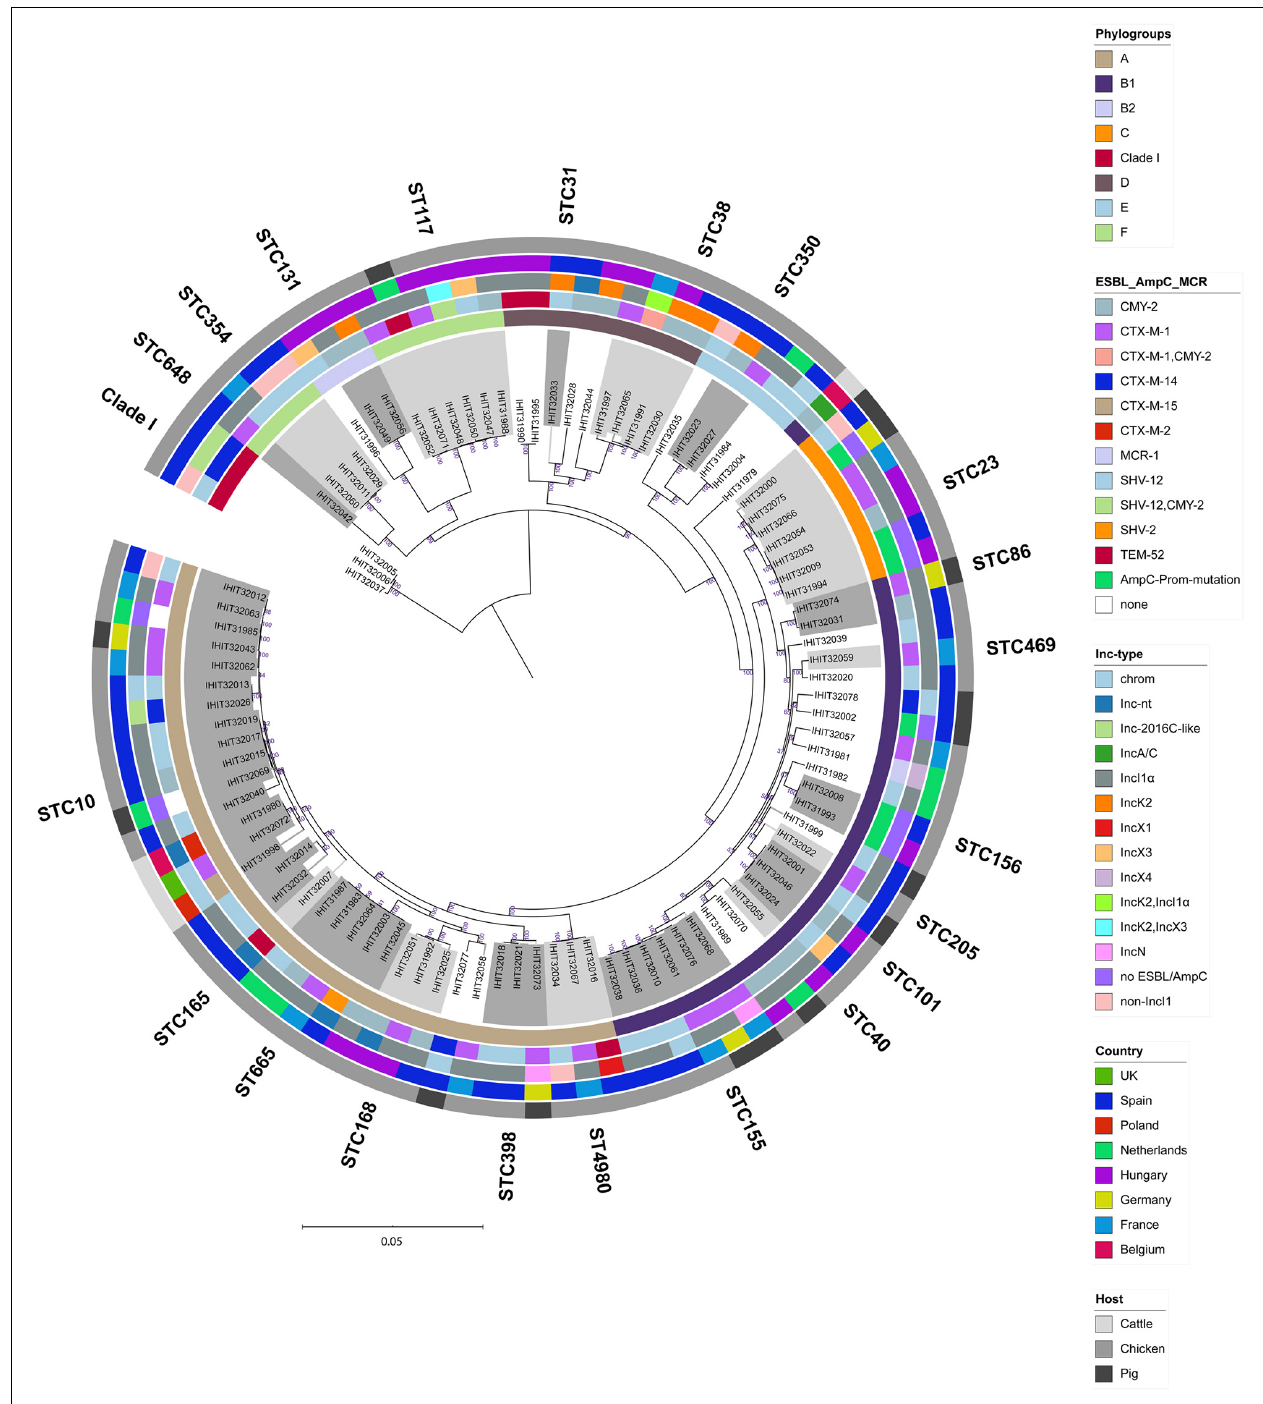
FIGURE 3 | Maximum-likelihood tree of 98 E. coli genomes ( E. fergusonii isolate IHIT32041 was not included). The phylogeny is based on 1336 orthologous genes and was calculated by RAxML. Graphical visualization was achieved by iTOL v5. Colored rings represent (from inner to outer ring the (i) phylogroup, (ii) ESC-non-S/ESC-R resistance determinant, (iii) ESBL/AmpC/MCR-1 plasmid replicon type, (iv) country of isolation, and (v)